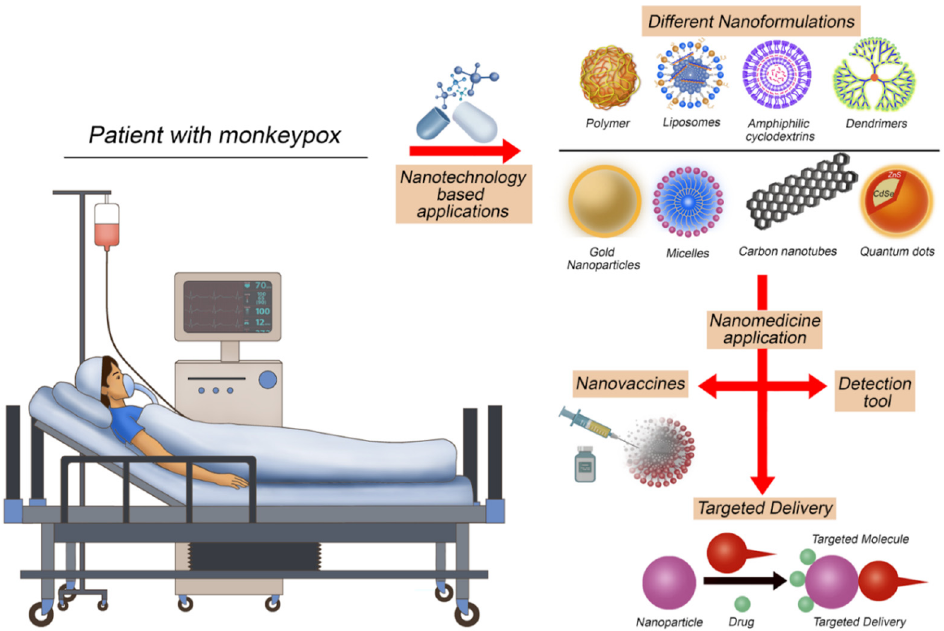
Figure 4. Nanotechnology applications that could be used to face the current monkeypox epidemic.